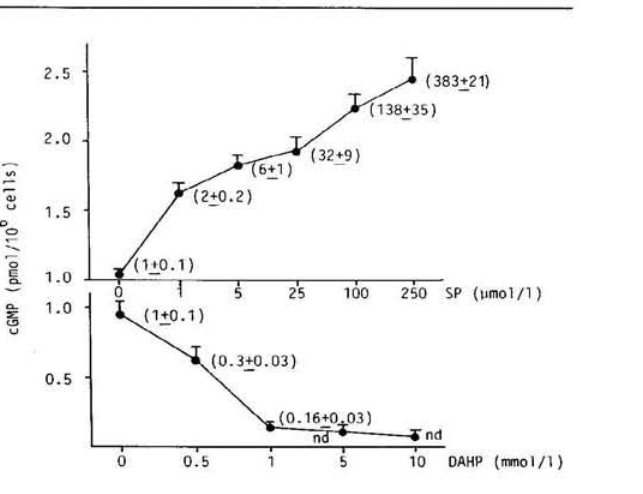
Figure 1. Influence of DAHP and of sepiapterin on NO syn- thase in human umbilical vein endothelial cells. Confluent monolayers of endothelial cells were treated for 24 hours with various concentrations of DAHP and sepiapterin. NO synthase was stimulated by 1 μΜ A23187 for 4 min and intracellular cGMP levels were detected by radioimmunoassay. Intracellular tetrahydrobiopterin was measured by HPLC and is given in paranthesis (pmol/10 6 cells). Values of three experi- ments + SD are